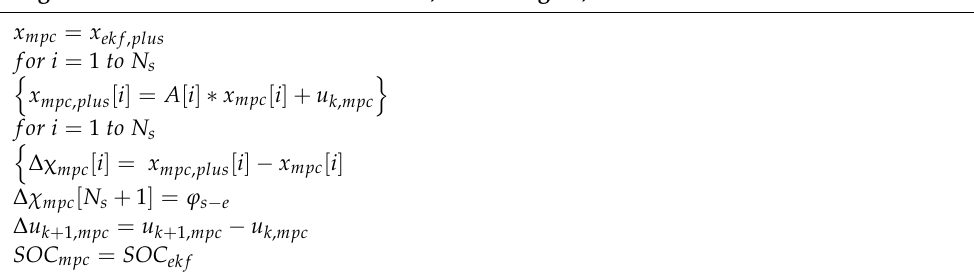
Algorithm 10: MPC initialization of state, control signal, and